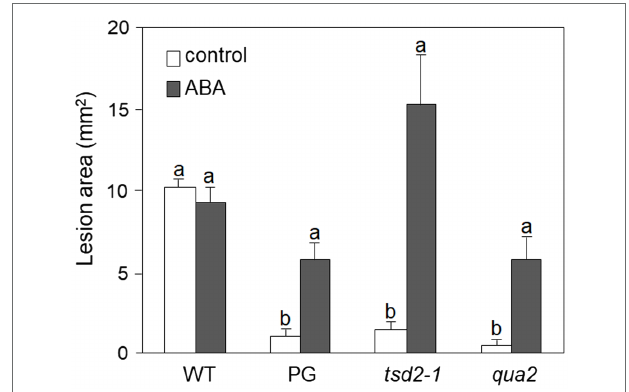
FIGURE 2 | Resistance to Botrytis cinerea conferred by altered HG is suppressed by exogenous ABA. Rosette leaves of five-week-old WT, PG, qua2 , and tsd2-1 plants were treated with 0.01% MeOH (white bars) or 100 μ m ABA (grey bars) and, after 24 h, inoculated with a B. cinerea spore suspension. Lesion area was measured 2 days after inoculation ( n > 10 lesions for each genotype). Bars indicate average lesion area ± SE . Different letters indicate statistically significant differences, according to two-way ANOVA followed by Tukey’s significance test ( p < 0.05). This experiment was repeated three times with similar